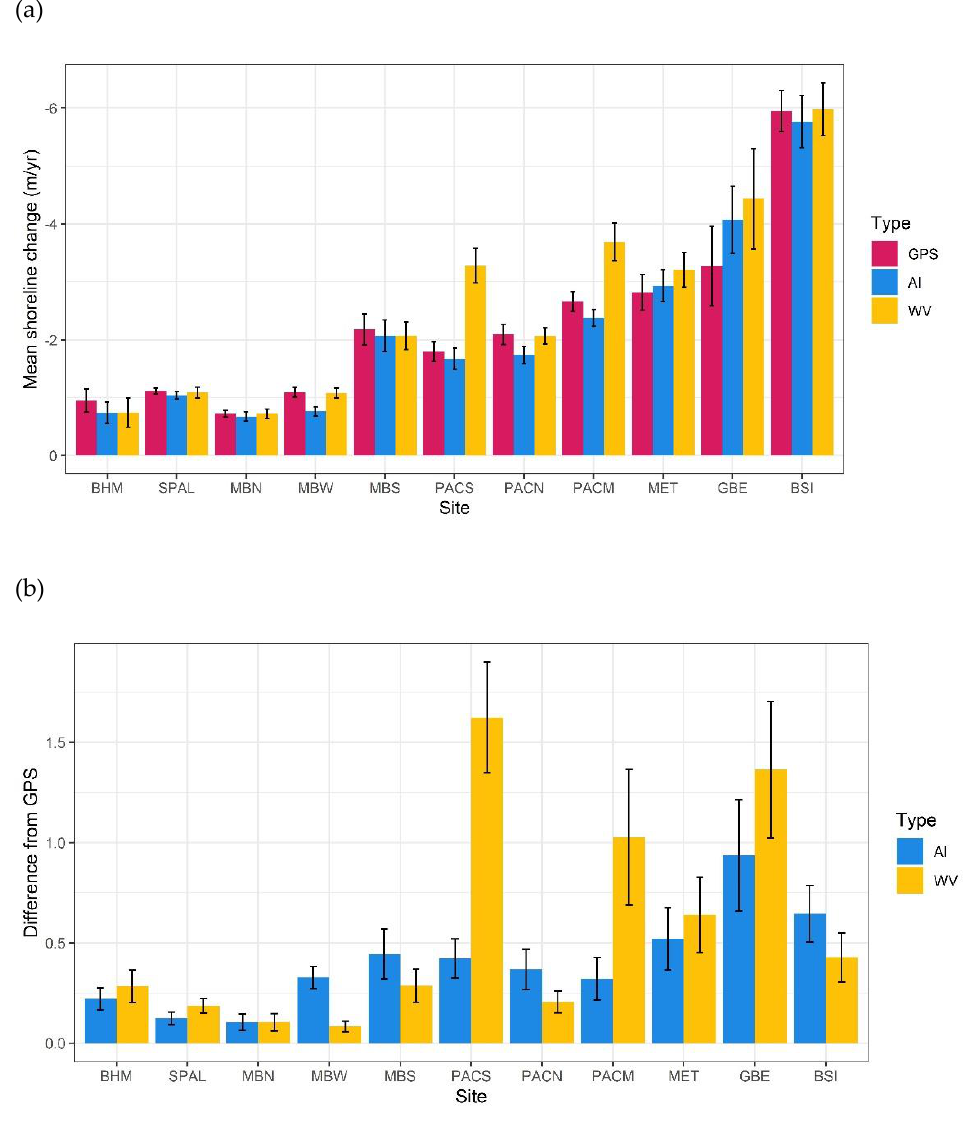
Figure 5. Mean shoreline change rate ( a ) and mean of the absolute difference between the shore- line change rate calculated using Global Position System (GPS) data and shoreline change from two remote sensing data sets: WorldView (WV) satellite imagery and aerial imagery (AI) ( b ).